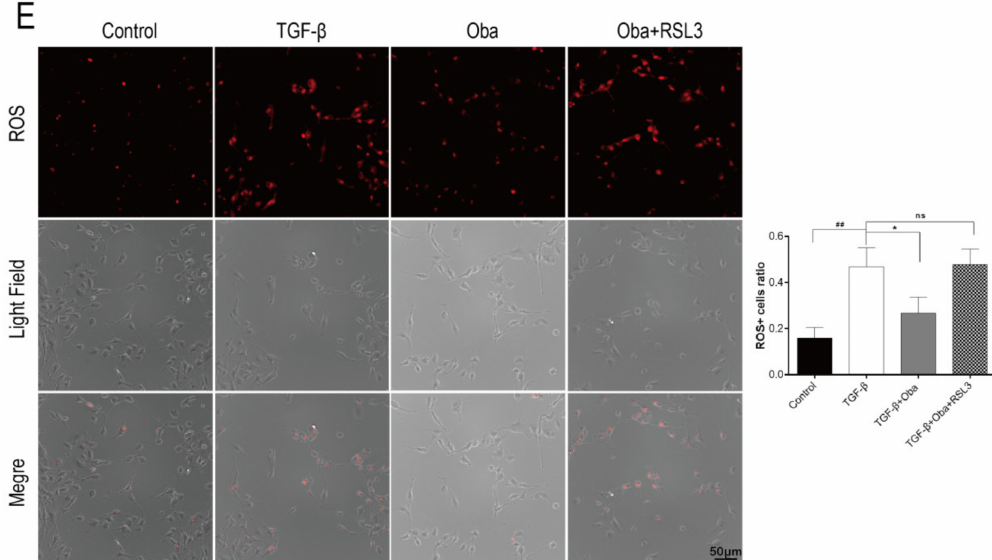
Figure 3. The anti-fibrosis effects of Oba were mediated by activated GPx-4-induced antioxidant capacity by reducing phospholipid oxidation. ( A ) Quantification of Nrf-2, Keap-1, and Nox-2 protein expressions as assessed by Western blotting in vitro. ( B ) Quantification of the GPx-4 protein expression as assessed by Western blotting in vitro. ( C ) The effects of RLS3 (0–6 µ M, 24 h/48 h/72 h) on the Lx-2 cell viability as determined by the CCK8 kit in accordance with the manufacturer’s protocol. ( D ) Quantification of GPx-4, α -SMA, and collagen-1 protein expression as assessed by Western blotting with the interference of RSL3 in vitro. ( E ) Reactive oxygen species (ROS) (red) staining by Dihydroethidium (DHE). Cell mor- phology was observed under bright-field microscopy. The results were expressed as means ± SEM ( n ≥ 3). ns (italic), # , ## , ### indicate p > 0.05, p < 0.05, p < 0.01, p < 0.001 compare with control group; ns, *, **, *** indicate p > 0.05, p < 0.05, p < 0.01, p < 0.001 compared with model